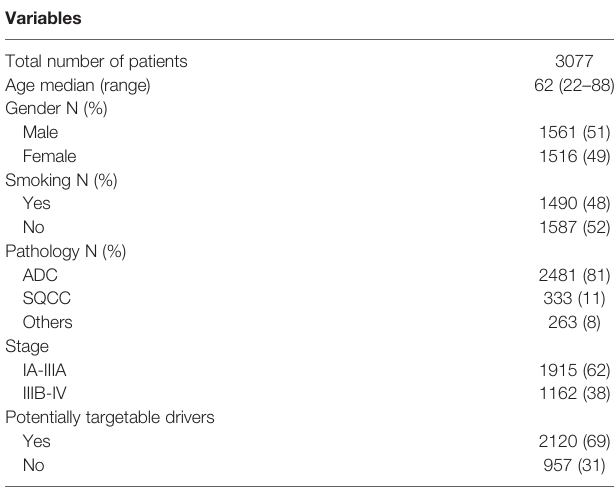
TABLE 1 | Demographic and clinico-pathological characteristics of all patients who underwent NGS.